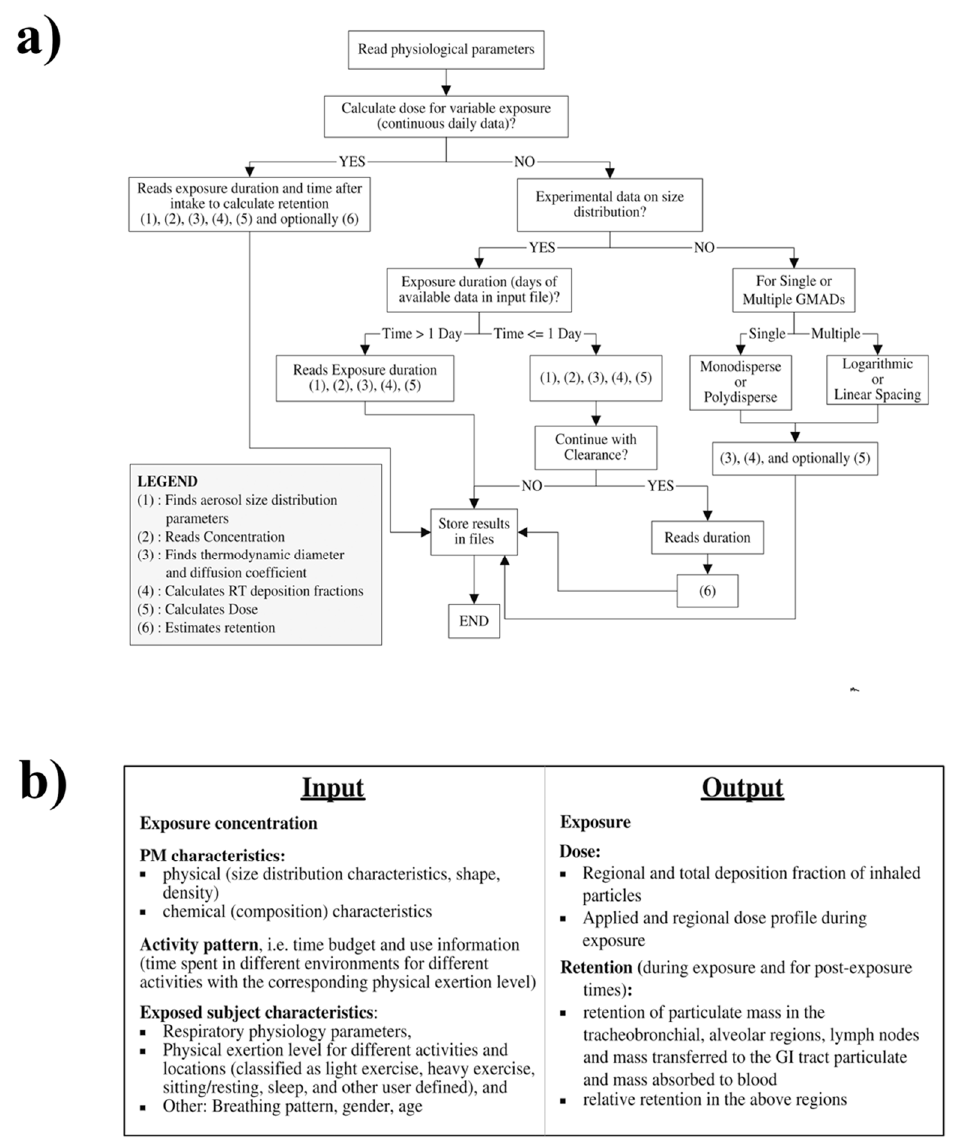
Figure 5. The workflow (a) and input / output data (b) for the Exposure Dose Model (ExDoM) [39]. Reprinted with permission from [39]. Copyright 2013, Springer.